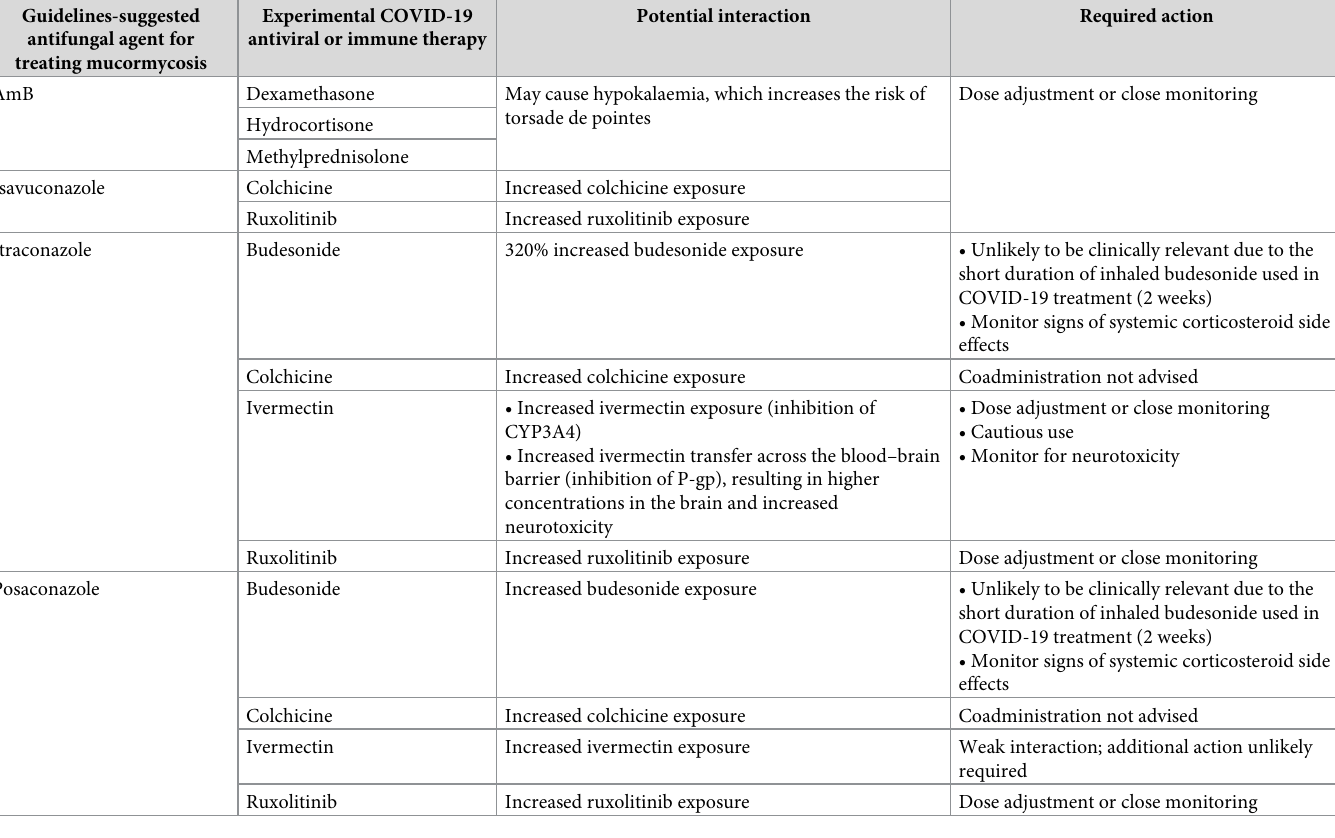
Table 3. Potential drug–drug interactions of guidelines-suggested antifungal agents for treating mucormycosis with experimental COVID-19 antiviral or immune therapies [86]. Guidelines-suggested antifungal agent